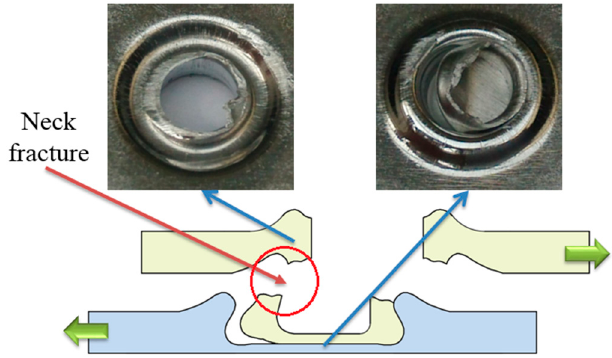
Figure 11. Neck fracture mode in the shearing test.